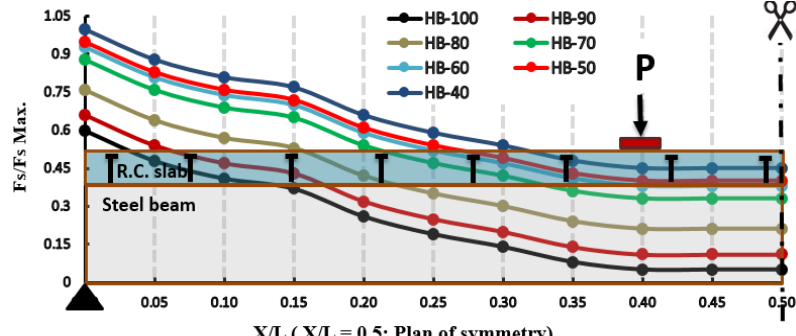
Figure 7: Ratio of stud forces to its relative